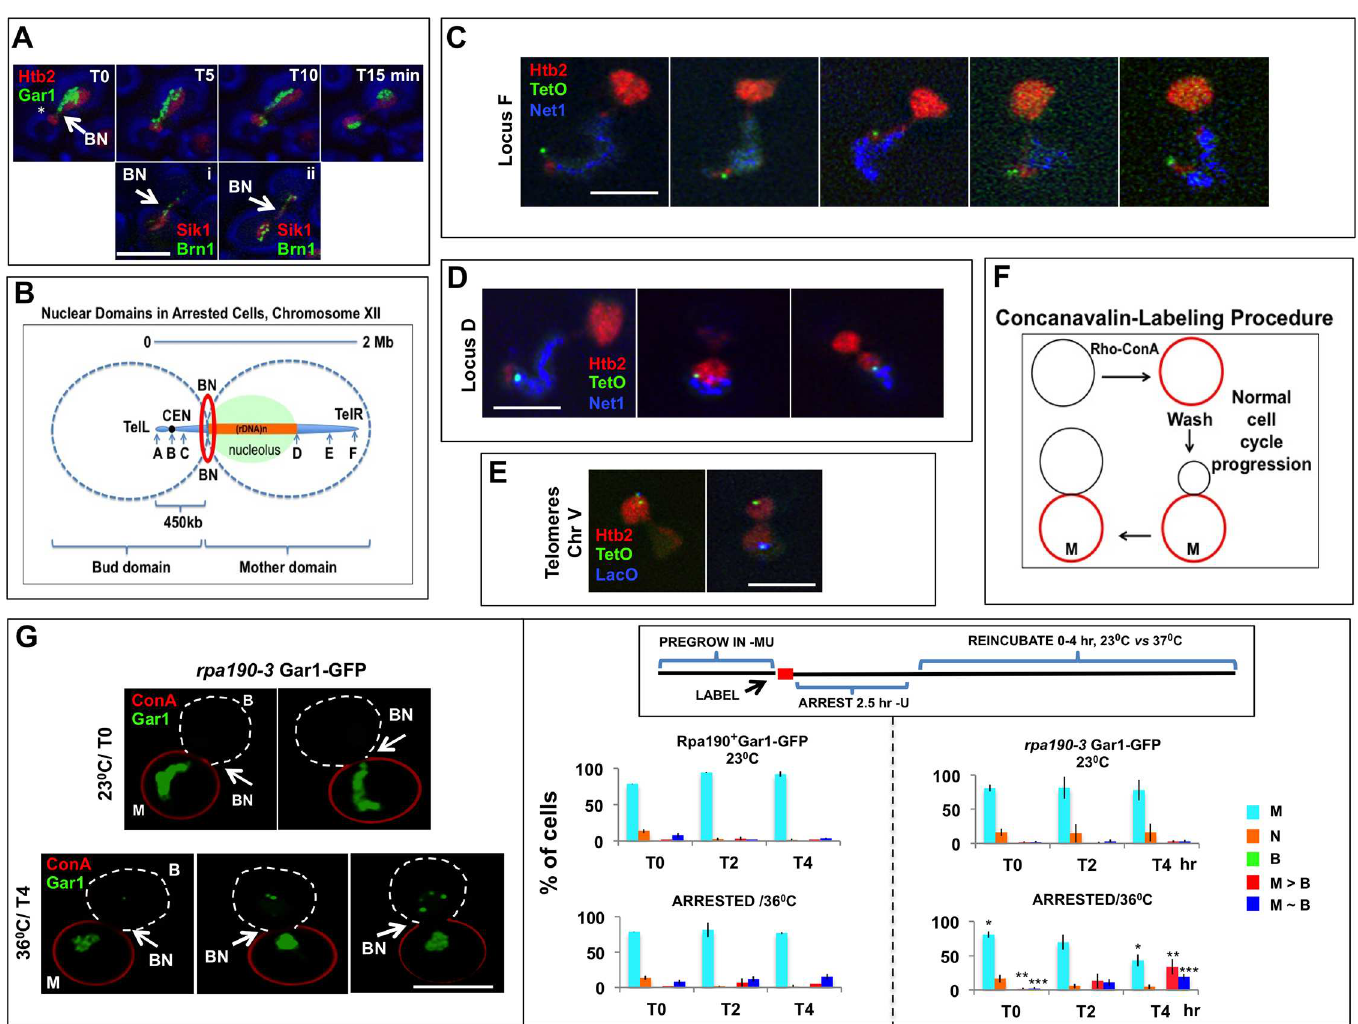
Fig 3. Polarity of Chromosome XII and the Nucleolus. (A) Distributionand coherenceof the nucleolus. The top panelsillustrate the relative behavior of a nucleolarprotein (Gar1-GFP) and Htb2-mRFP duringentry into anaphaseof a normal cell cycle. Note that a limited amount of chromatinemergedinto the bud domainat an early time-point( * ) after being constricted at the level of the bud neck. The nucleolarsignalthen follows slowly, remaining in contact with the stretched chromatinmass. It subsequently is resolvedinto two equal parts that associate with the chromatinmasses. Strain: ATY2416. The lower panels illustrate an intermediate time point when two nucleolar markers can be seen to traverse the neck duringthe normalcell cycle. These are the condensin, (Brn1-GFP) (that coats compacted rDNA and defines a narrowthread), and Sik1-mRFP, that occupiesa broaderterritory. Both markers are compressedas the nucleolus traverses the bud neck region. Strain: ATY7473.(B) Schematic representation of nuclear domainsand chromosome XII in arrested cells. The diagram illustrates the anticipated positionof chromosomeXII when the nucleolus(green)abuts on the bud neck. The positionof the septin ring is also indicated, suggestingthat this ring—in conjunction with the nucleolus—couldcontrol passageacross the neck. The lacO or tetO loci that we have followedare from the followingstrains: locus A (ATY7633), locus B (ATY7634), locus C (ATY7733), locus D (ATY7241), locus E (ATY7637)and locus F (ATY7102). (C) Distributionand organization of telomere XII after arrest. Images of a MET3-CDC20 strain that expressesHtb2-mRFP, Net1-CFP and a tetO tag at locus F (TelR). In the arrested cells, the tail portion of the chromatin and Net1-CFP (blue) were in the mother domain, whereasthe mass of chromatinwas in the bud domain.Note that when the tail was fully extended, the red extremity and the tetO locus were distal to Net1-CFP. The portion of the Htb2-mRFP signal corresponding to the nucleoluswas relatively faint, perhapsbecauseit is actively transcribed[36]. Strain: ATY7102. (D) Distributionof rDNA: Images of a MET3-CDC20 strain that expresses Htb2-mRFP, Net1-CFP and a tetO tag at locus D. Cells were arrested by additionof methionine for 4 hours and then imaged.Note that, by contrast to cells with a tagged telomere, the tagged locus abutted on the Net1-CFP signal and that—whenthe tail was maximally extended—this locus was not within the red telomericregion. Strain: ATY7241. (E) Distributionand organizationof the telomeres of chromosomeV: A MET3-CDC20 strain expressingHtb2-mRFP, TelVL-tetO and TelVR-lacO along with YFP-tetR and CFP-lacI was arrested by additionof methionine for 4 hours. In some cells, both TelVL-YFP and TelVR-CFP were locatedin a single domain(left), while in other cells, the signalswere each in a different domain (right). Strain: ATY7272. (F) Concanavalin stainingof cells: Cells were stainedwith rhodamine-conjugated ConA for 15 minutes on ice. The cells were then washedand reincubated. The diagramindicates the staining pattern that was observed before and after reincubationto allowbud growth. (G) Localization of Gar1-GFP in rpa190-3 ts mutant cells: Images on the left: A MET3-CDC20 rpa190-3 strain expressingGar1-GFP was labeledwith rho-Con A and arrested by additionof methionine at 23˚C. The cells were then shifted to 36˚C (or not) and studiedafter 0–4 hours. The two upper images show that, before